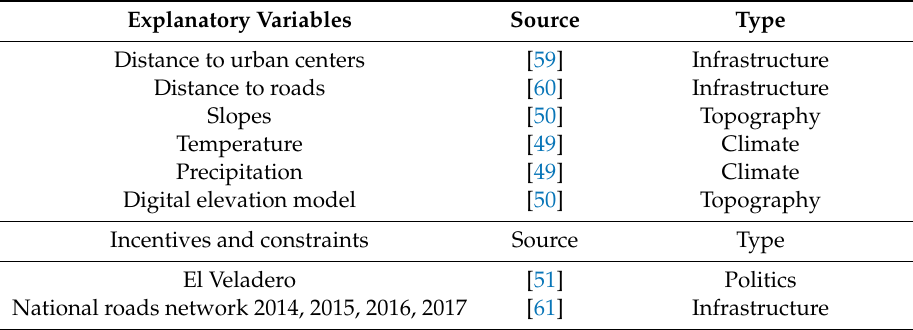
Table 1. Explanatory variables, incentives and constraints.